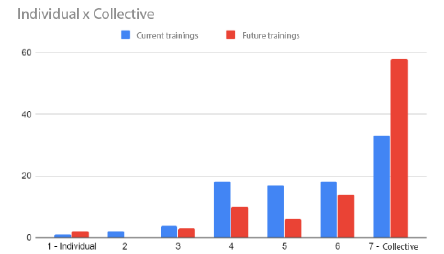
Figure 6. Vision of electricians and instructors about current and fu- ture trainings: individual x collective.